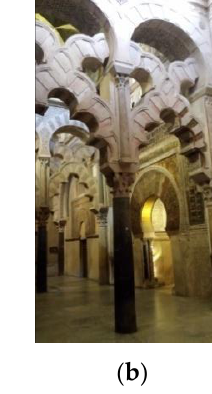
Figure 3. Inner view: ( a ) columns forest and ( b ) Royal Chapel. Source: Own photographs.